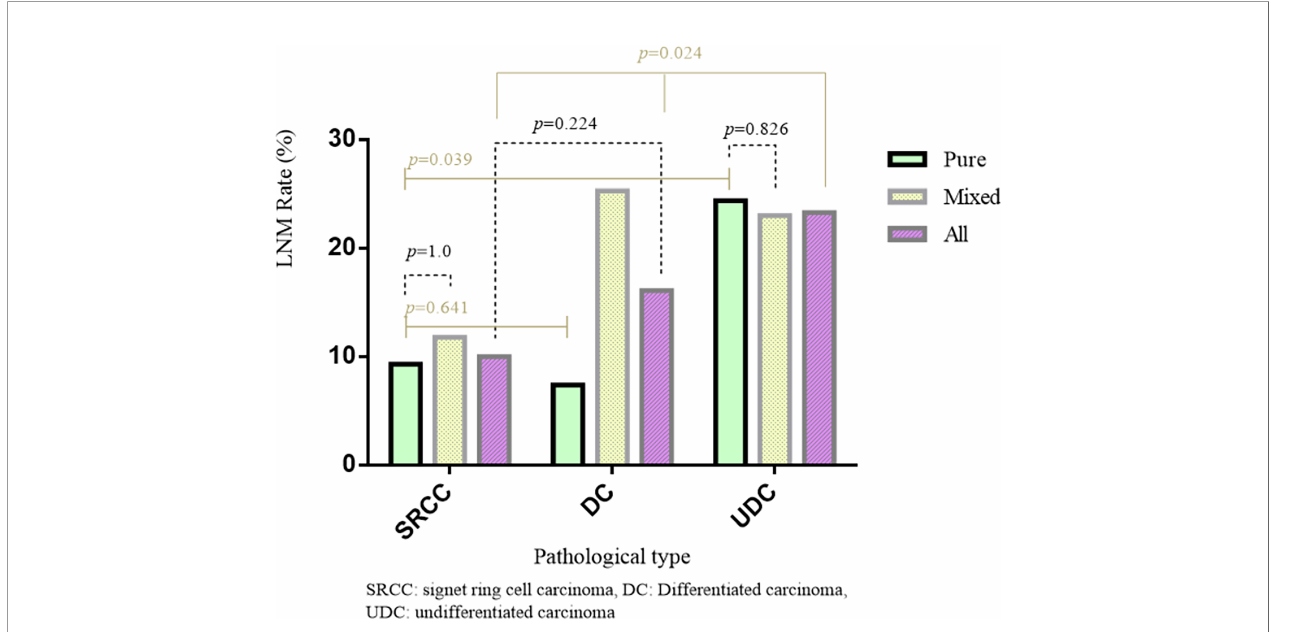
FIGURE 1 | The difference of LNM between puremixed type in different pathological of